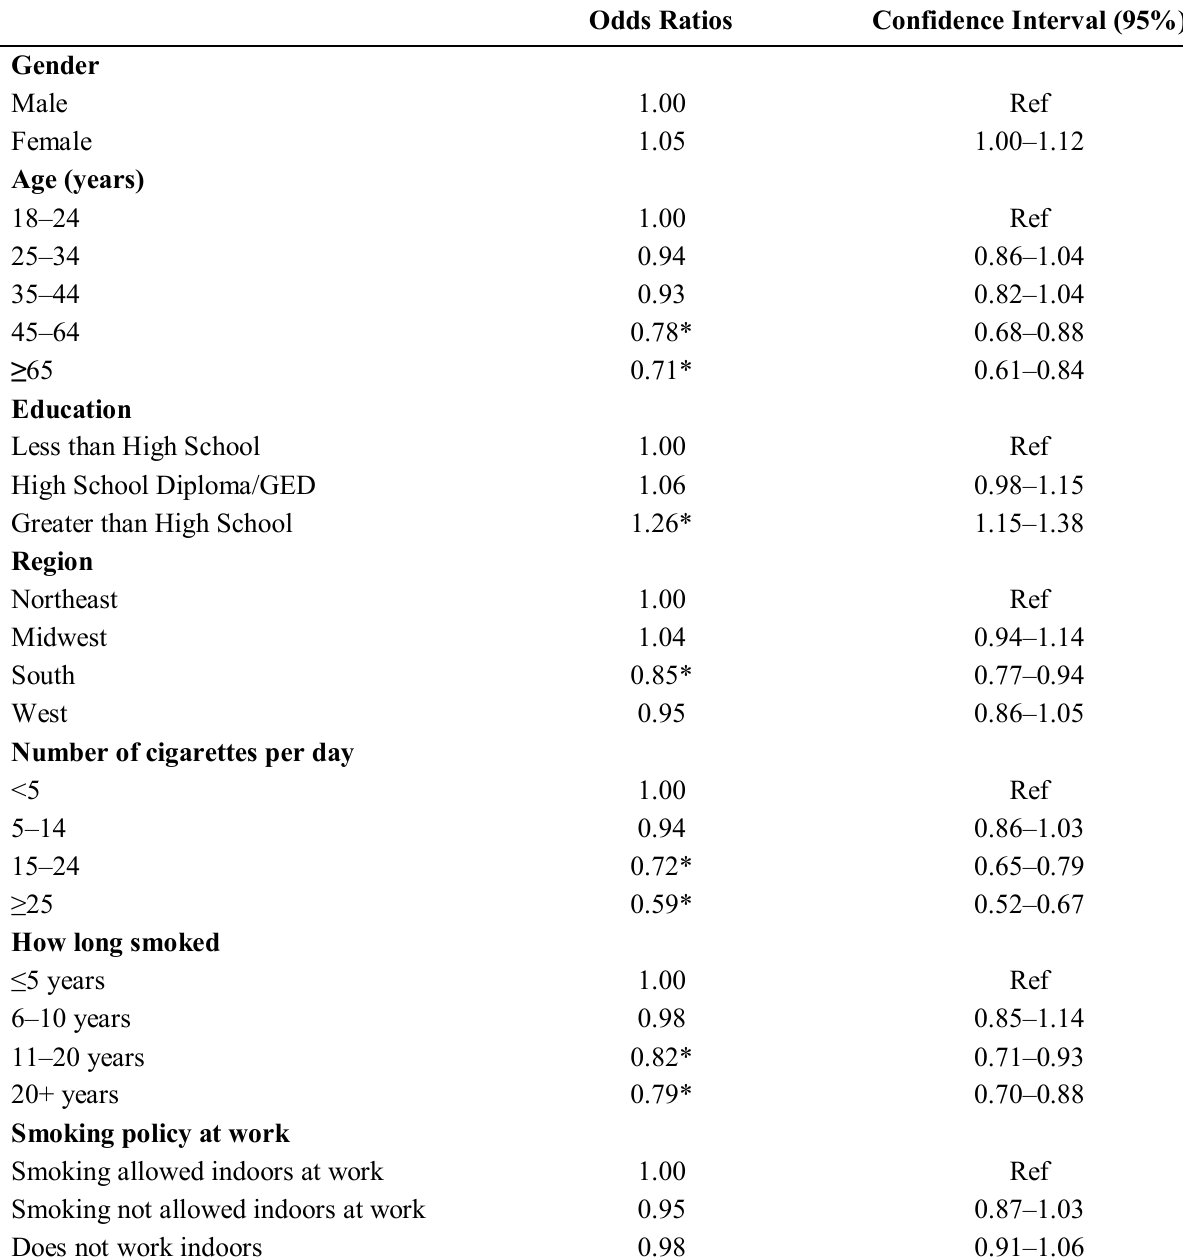
Table 3. Adjusted odds ratios from final multivariate logistic regression model Ж for correlates of having a quit attempt in the past year among smokers Ф . Odds